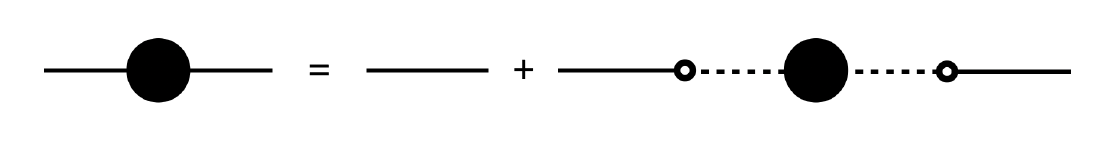
Figure 6. “Dressed” phonon propagator in terms of the exact dislon